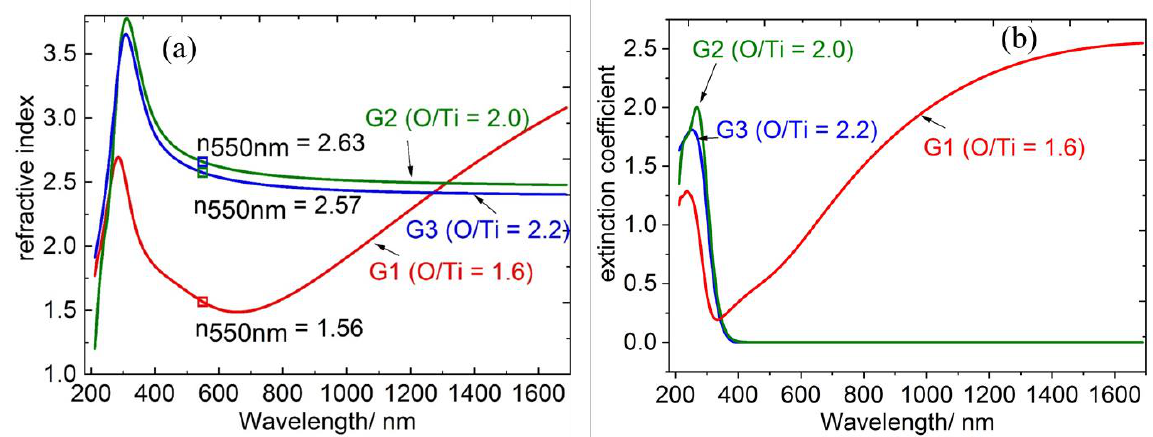
Figure 10. Refractive index ( a ) and extinction coefficient ( b ) in the 200–1700 nm wavelength range for one representative sample of group 1 (red), 2 (green), and 3 (blue). The refractive index at 550 nm is marked as an open square and the actual value is included in the graph.